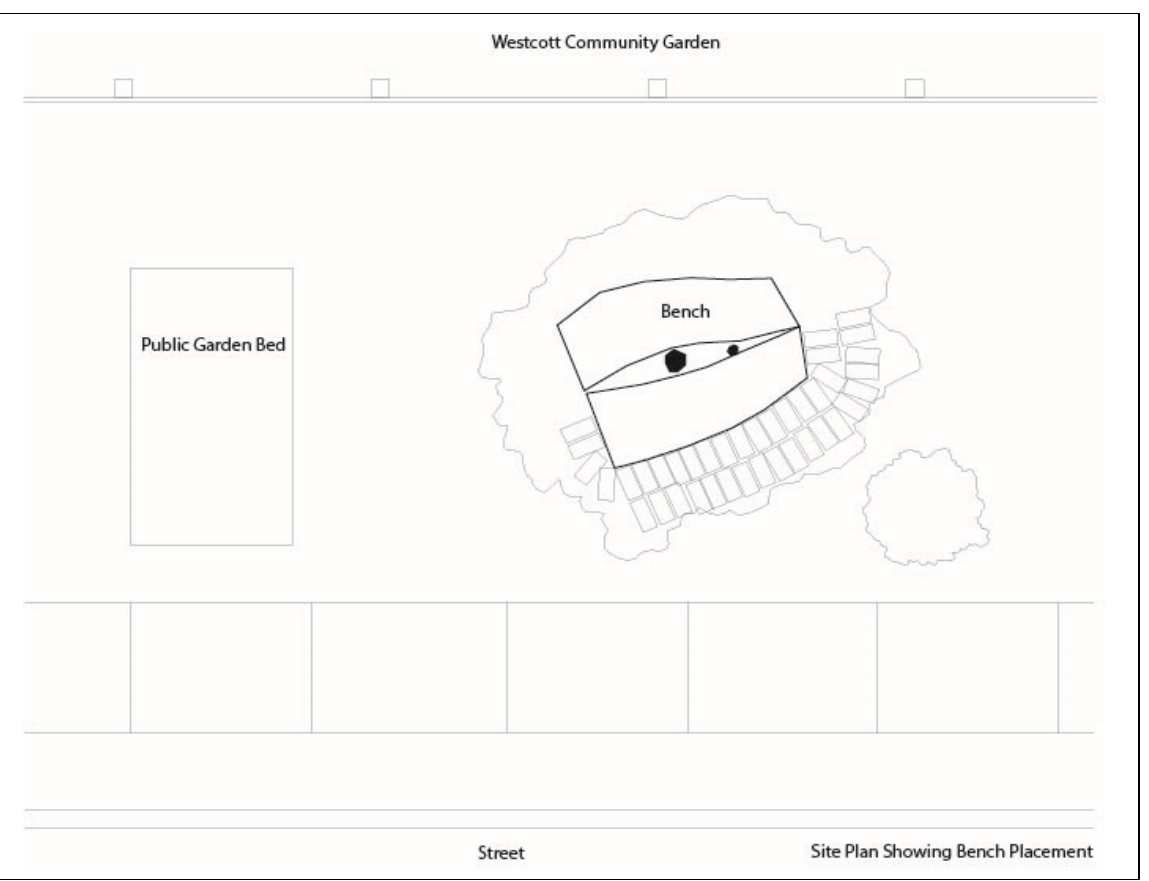
Figure 2. Diagram of the location of the